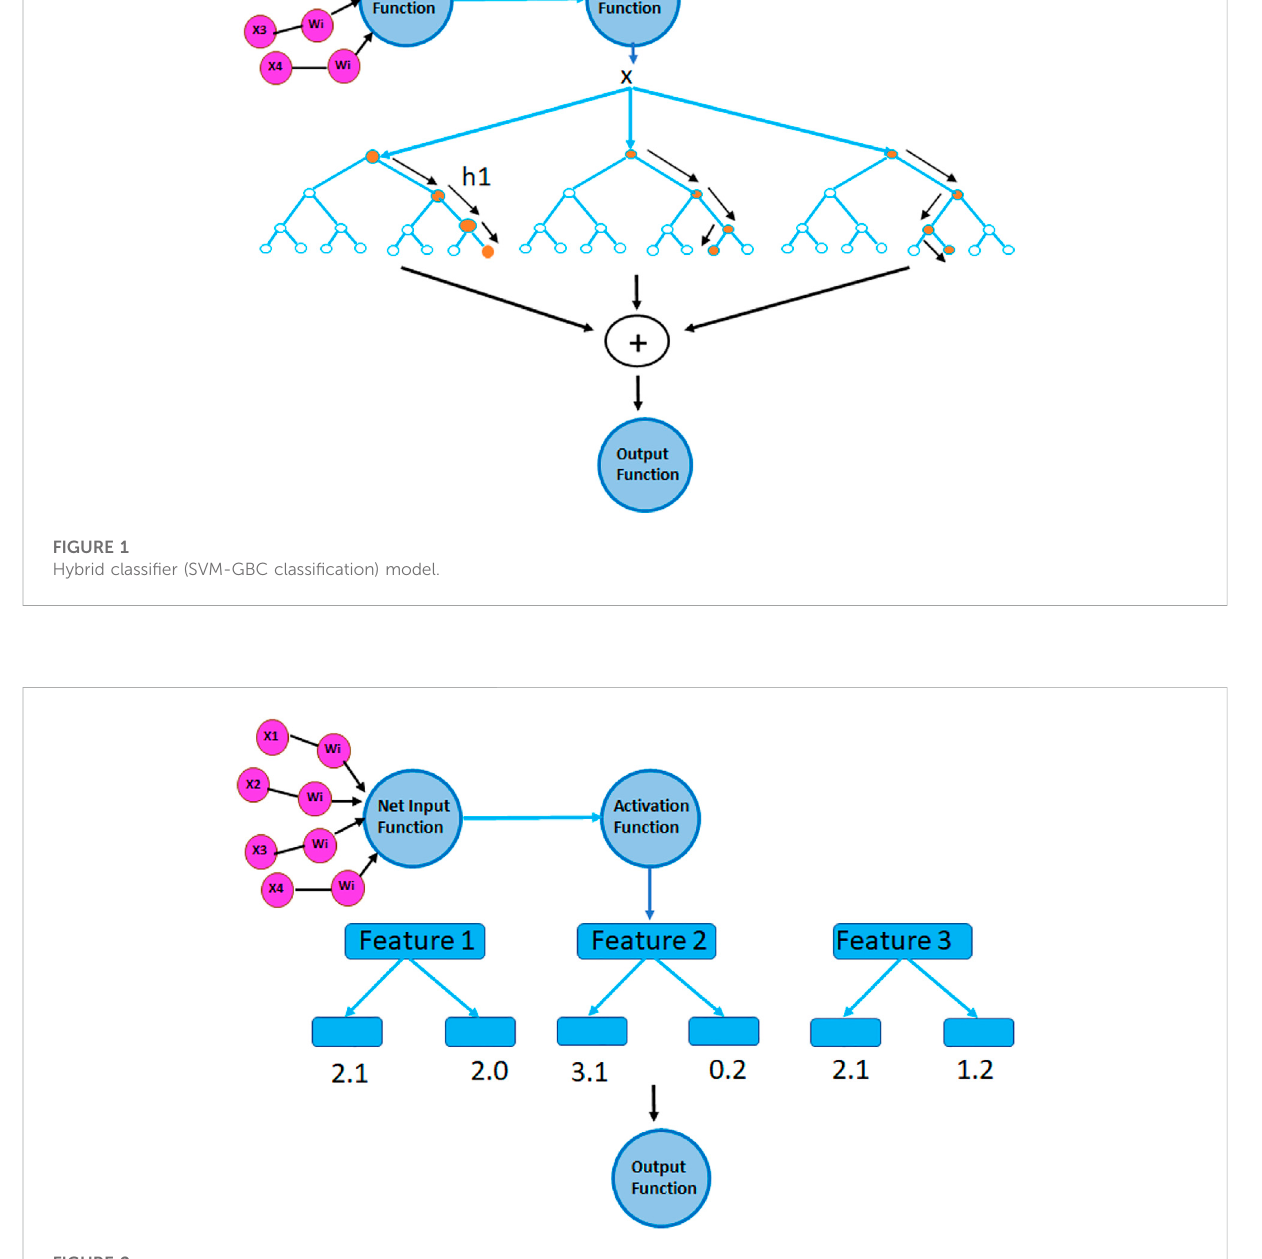
FIGURE 2 Hybrid classi fi er (SVM-ABC classi fi cation)